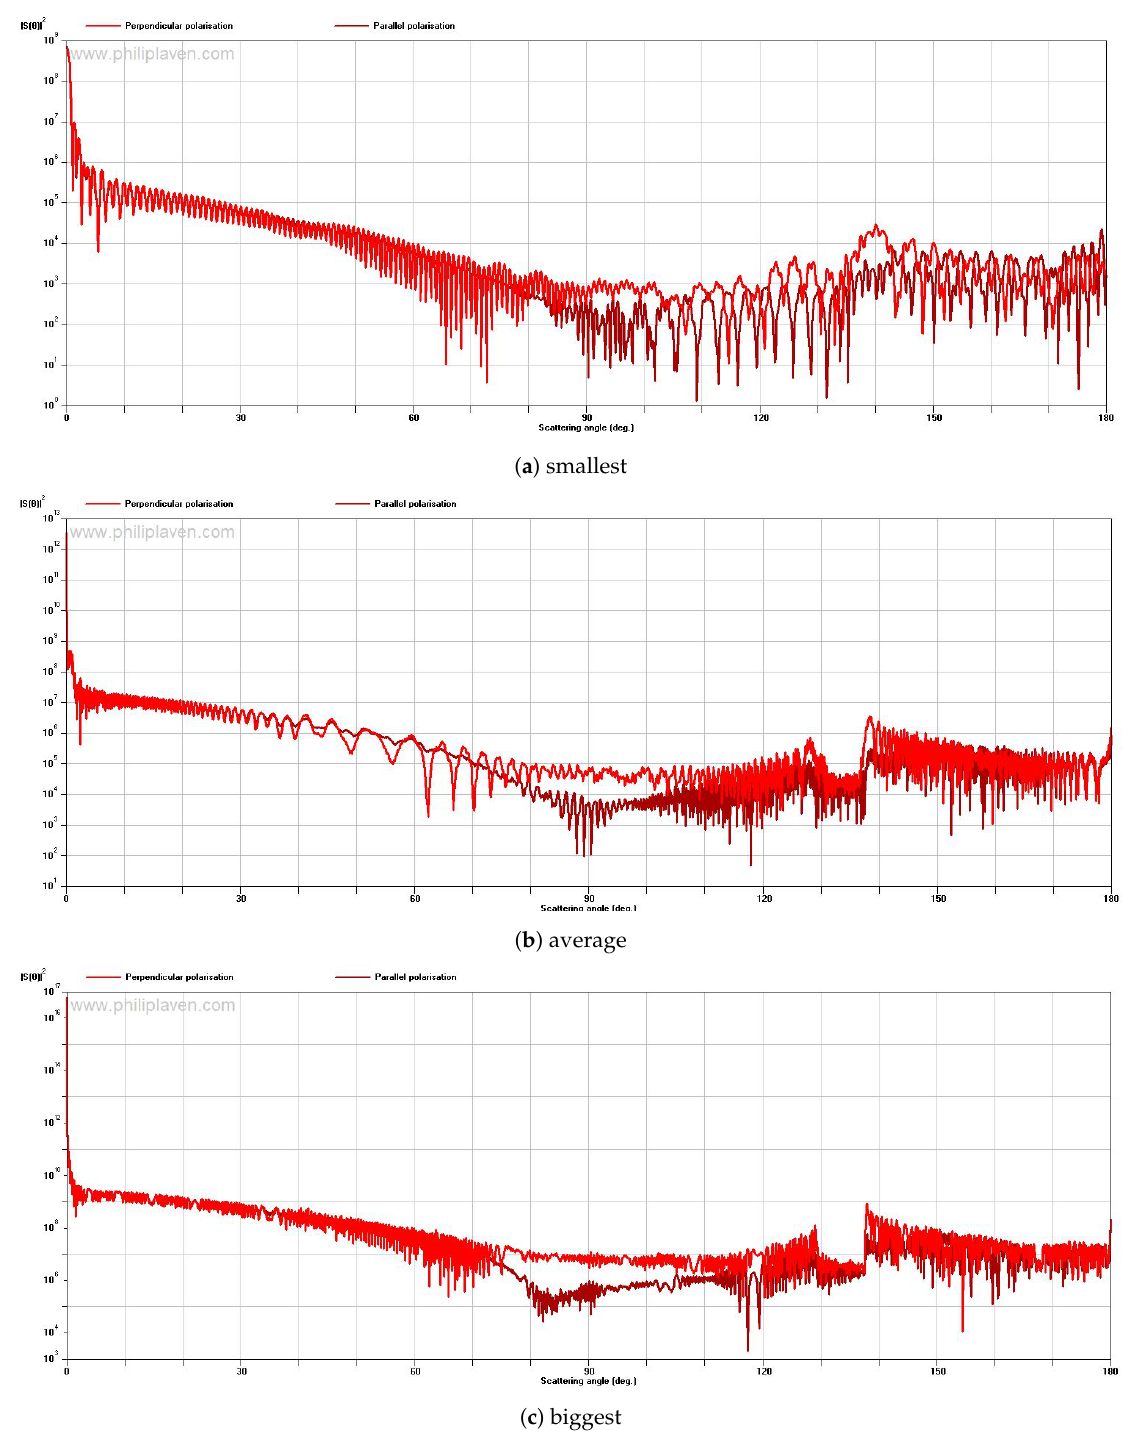
Figure 6. Scattering intensity vs scattering angle for ( a ) smallest, ( b ) average and ( c ) biggest